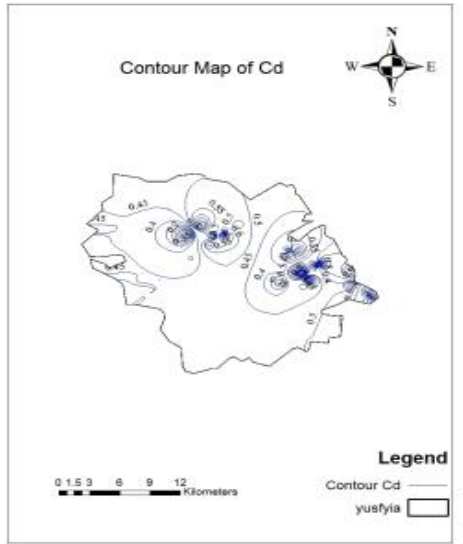
Fig.19: The interpolation and contour line of Pb map in ppm .